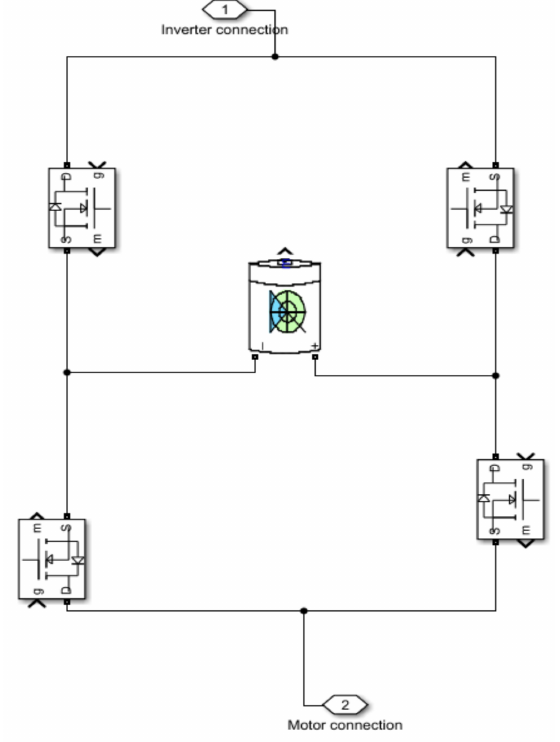
Figure 5. Simulink model of the battery